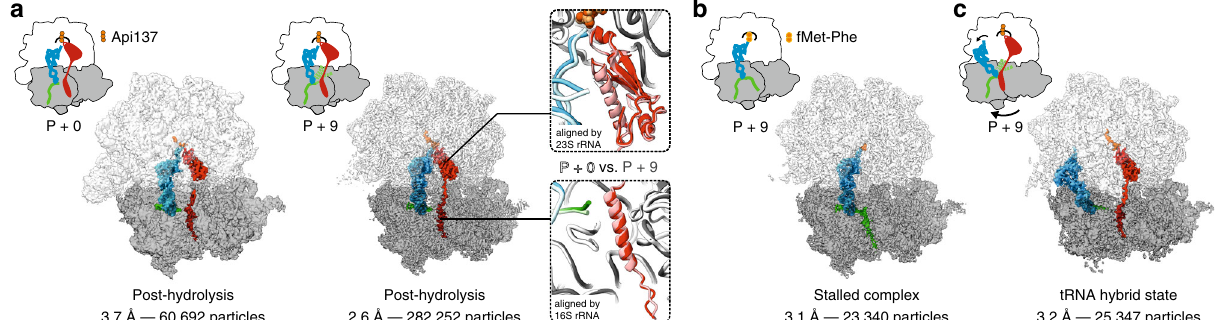
Fig. 2 Structural intermediates of ribosome rescue by ArfB as visualized by cryo-EM. For cryo-EM analysis, ArfB was trapped on the ribosome using the antimicrobial peptide Api137. a Major states of ArfB-bound P + 0 and P + 9 complexes exhibit a striking structural similarity. Close-ups: Superposition of P + 0 (lighter colors) and P + 9 (darker colors) structures in the PTC (top) and the DC region (bottom). b Stalled P + 9 complex with dipeptidyl-tRNA prior to ArfB binding. c Post-hydrolysis P + 9 complex with P/E hybrid tRNA. Note the lack of density for mRNA in the mRNA entry channel in the ArfB-bound P + 9 states indicating a highly fl exible 3 ′ extension of mRNA versus the well-de fi ned 3 ′ extension in the vacant P + 9